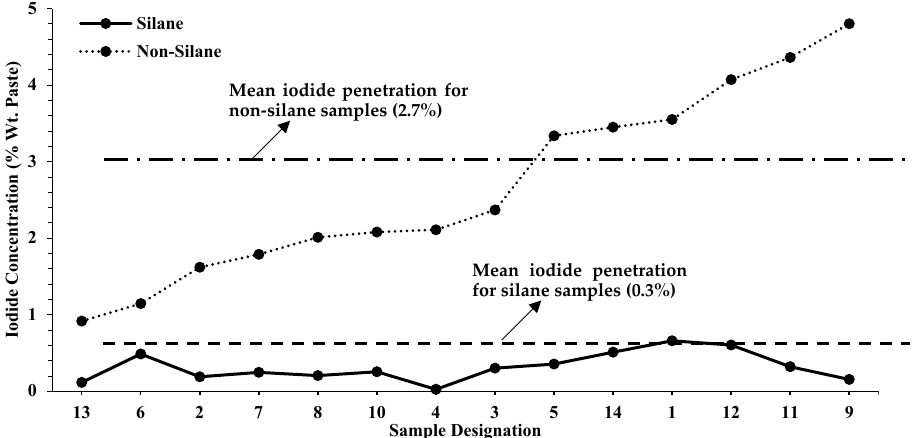
Figure 7. Comparison of silane vs. non-silane samples at 2 mm depth.